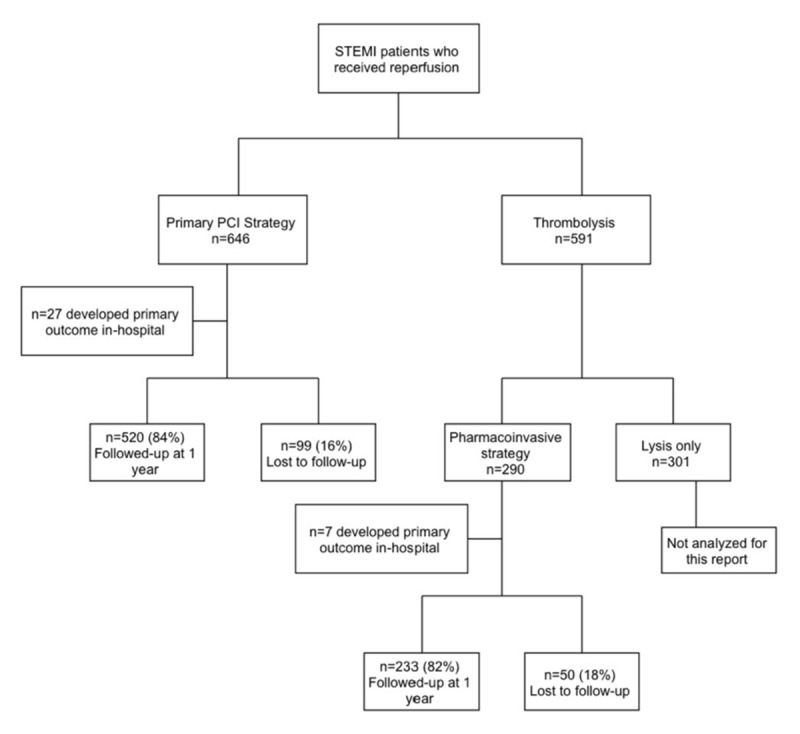
Flowchart of Patient Recruitment. A total of 1,237 STEMI patient were included in all-inclusive registry between September 2014 and September 2015; 646 patients underwent primary PCI with follow-up of 84% at one year. 290 patients underwent PhI with one year follow-up of 82%. We excluded 301 subjects who received lysis therapy only.